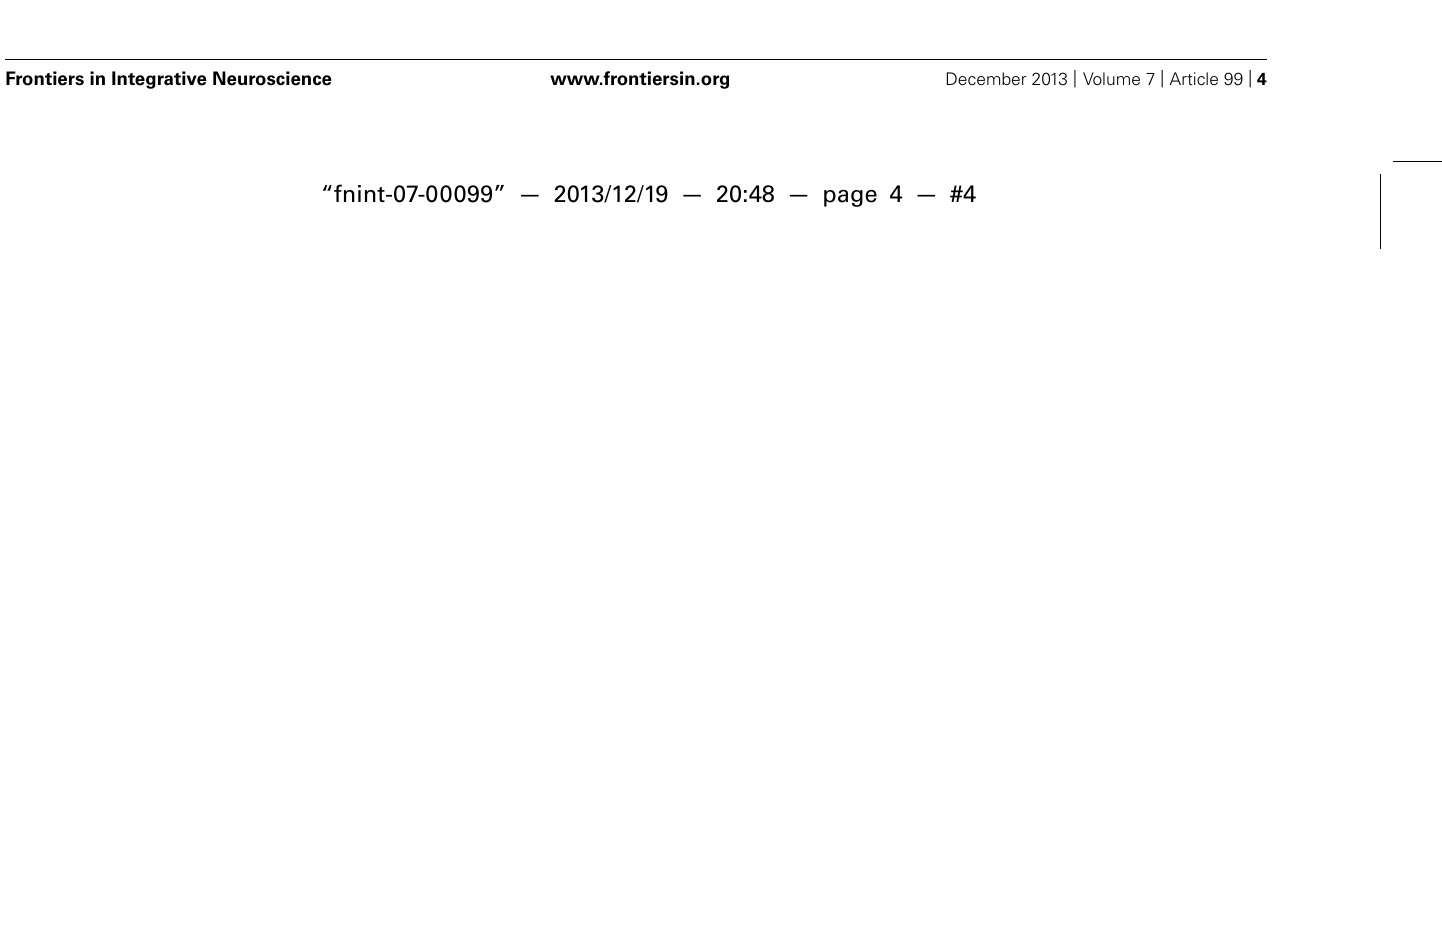
FIGURE 2 | Illustration of the thermo-modulation device comprising two headphone-mounted ear-probes and anAC powered control unit.